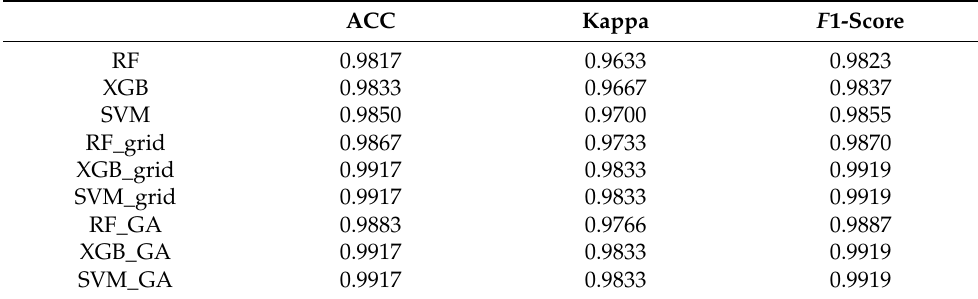
Table 4. Performance of ML models with default and optimized hyper-parameters using a genetic algorithm and grid search method on the validation site.